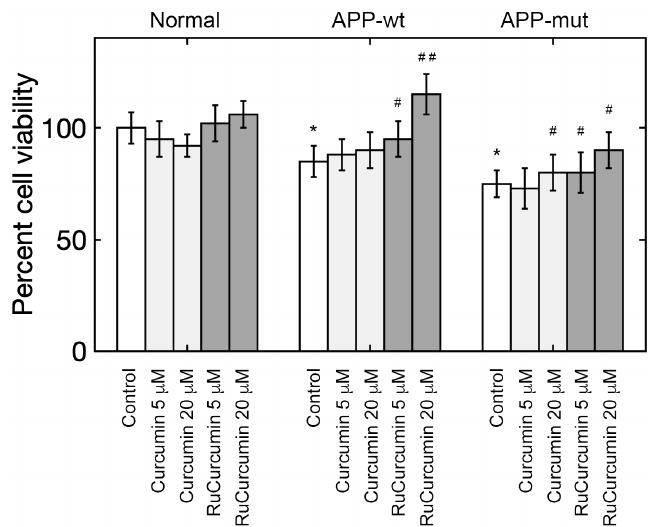
Figure 7. Effect of different concentrations of curcumin and RuCurcumin on normal and APP- transfected SH-SY5Y cells’ viability. Data points marked with an asterisk or hashtag are statistically significant with respect to normal control and to internal controls (APP-wt and APP-mut), respectively, to internal respective controls (*/ # p < 0.05; ## p <